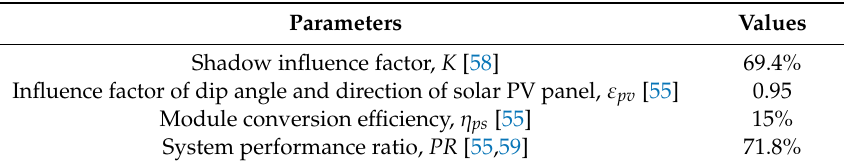
Figure 12. Monthly average solar radiation (kW h/m 2 ) data of Subang, Malaysia (2012–2014). Table 4. Parameters for solar PV panel calculation.